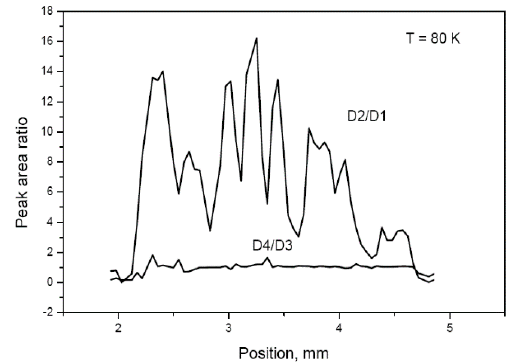
Figure 21. Spatial distribution of D2/D1 and D4/D3 peak area ratios along a profile measured in multi-crystalline Si at T = 80 K. The ratio D2/D1 varies strongly, whereas D4/D3 remains nearly constant [110].